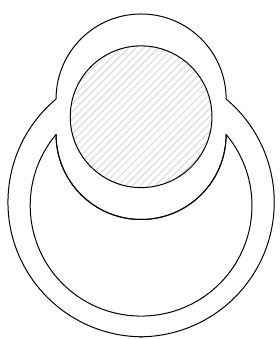
Figure 19. Bubble diagram obtained by joining the two external legs in figure